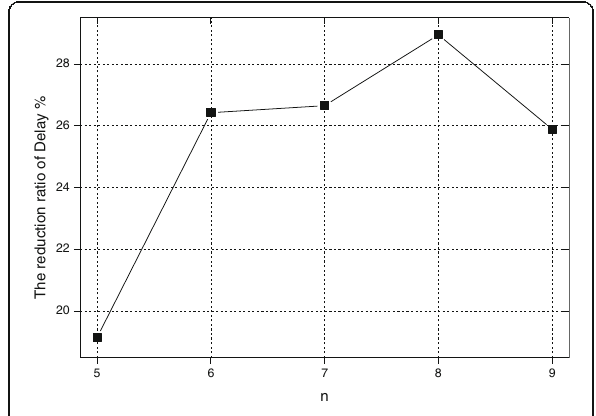
Fig. 26 The delay reduction ratio of UDCNP vs ODCNP